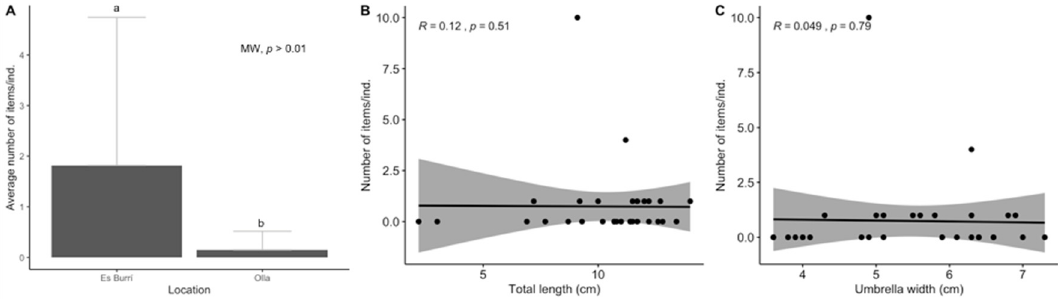
Figure 7. Results for the ingestion of anthropogenic particles in cnidaria samples: location ( A ) and Spearman rank correlation between the total length and the number of APs ingestion (significance level at p = 0.05) ( B ) and the width of the umbrella and the number of APs ingestion ( C ). The error bars for location indicate a 95% confidence interval and the significant differences are indicated by different letters. The significance level was established at p < 0.05.